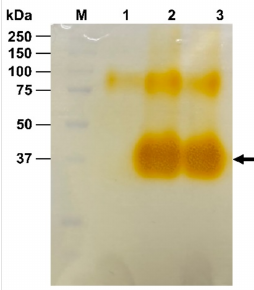
Figure 7. Native-PAGE image of MnP from Trametes hirsuta PW17-41 after reacting with ABTS and H 2 O 2 . Lane M = molecular weight marker (kDa); lane 1 = culture broth; lane 2 = (NH 4 ) 2 SO 4 precipitation; lane 3 =